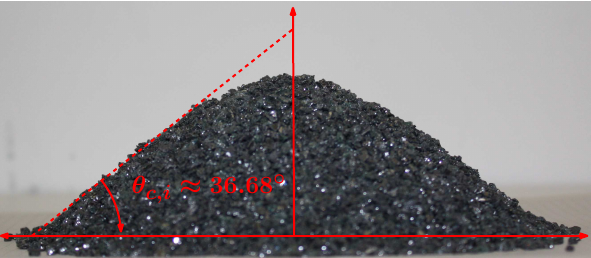
Figure 3. Quasistatic relaxation of a granular material initially contained within a cylinder.